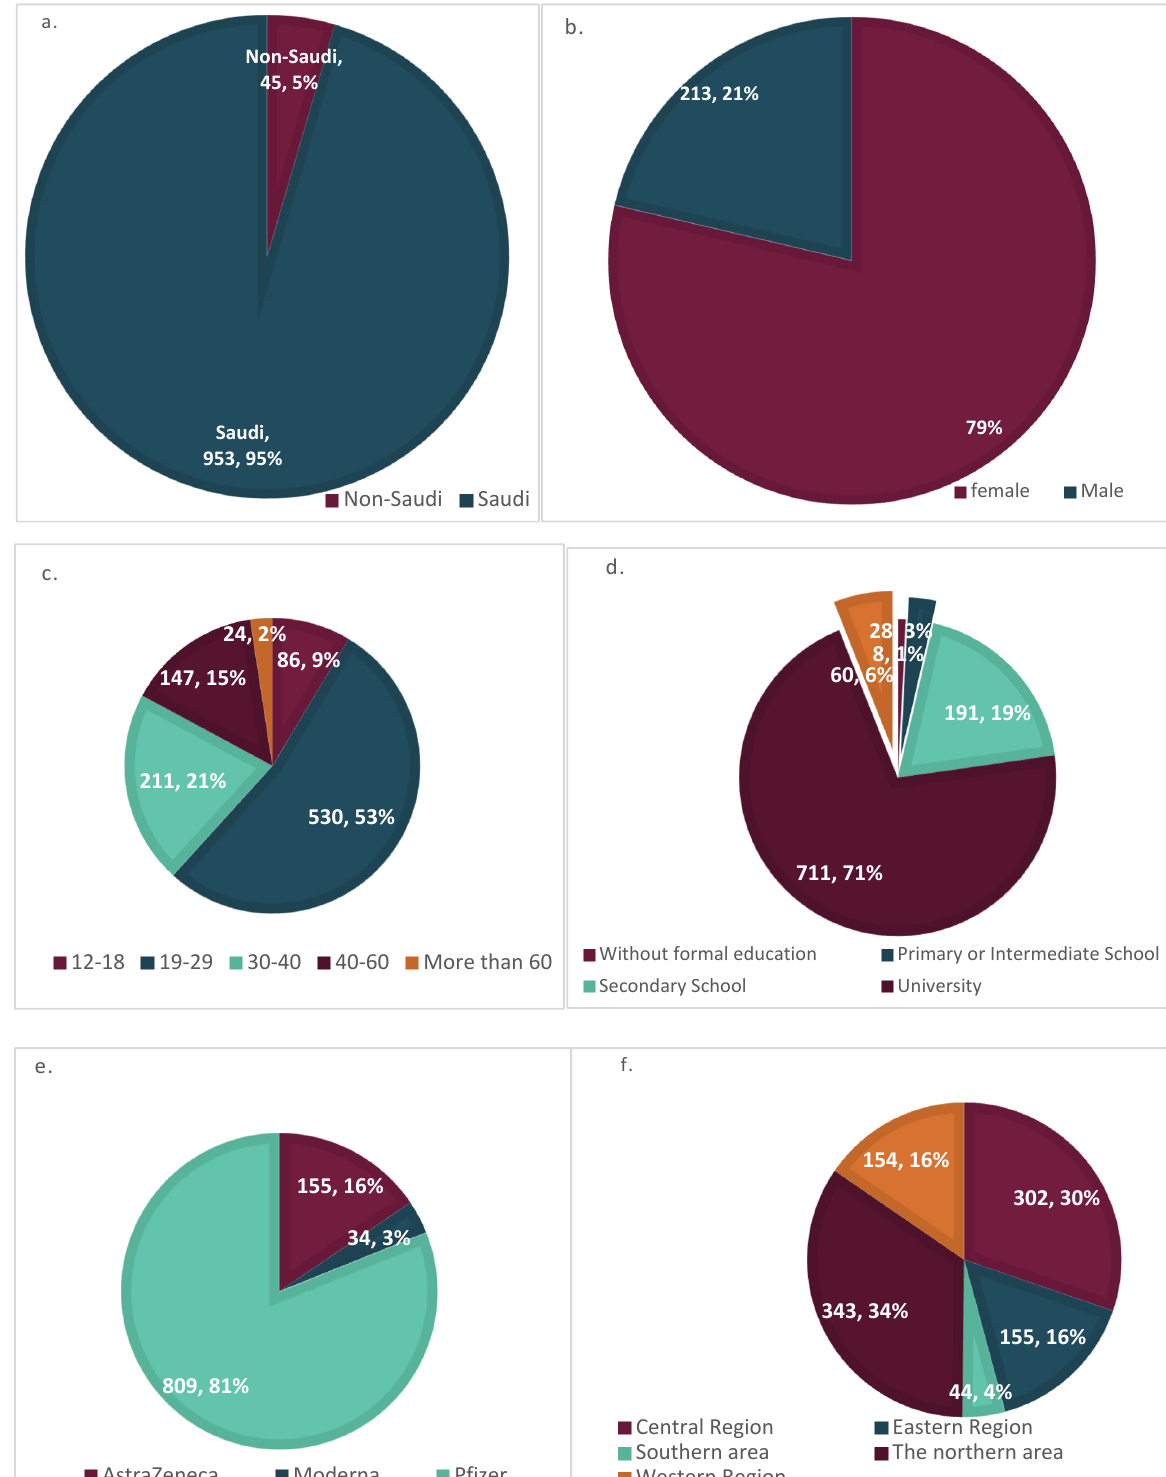
Figure 1. ( a ) Nationality-specific response to post-COVID-19 vaccine issues in Saudi Arabia. ( b ) Sex-specific response to post-COVID-19 vaccine issues in Saudi Arabia. ( c ) Age-specific response to post-COVID-19 vaccine issues in Saudi Arabia. ( d ) Education-specific response to post-COVID-19 vaccine issues in Saudi Arabia. ( e ) Overall vaccine-type administered by respondents in the study. ( f ) Region-specific respondents to post-COVID-19 vaccine issues in Saudi Arabia. Table 1. Frequency of different types of vaccines administered by respondents in the study.